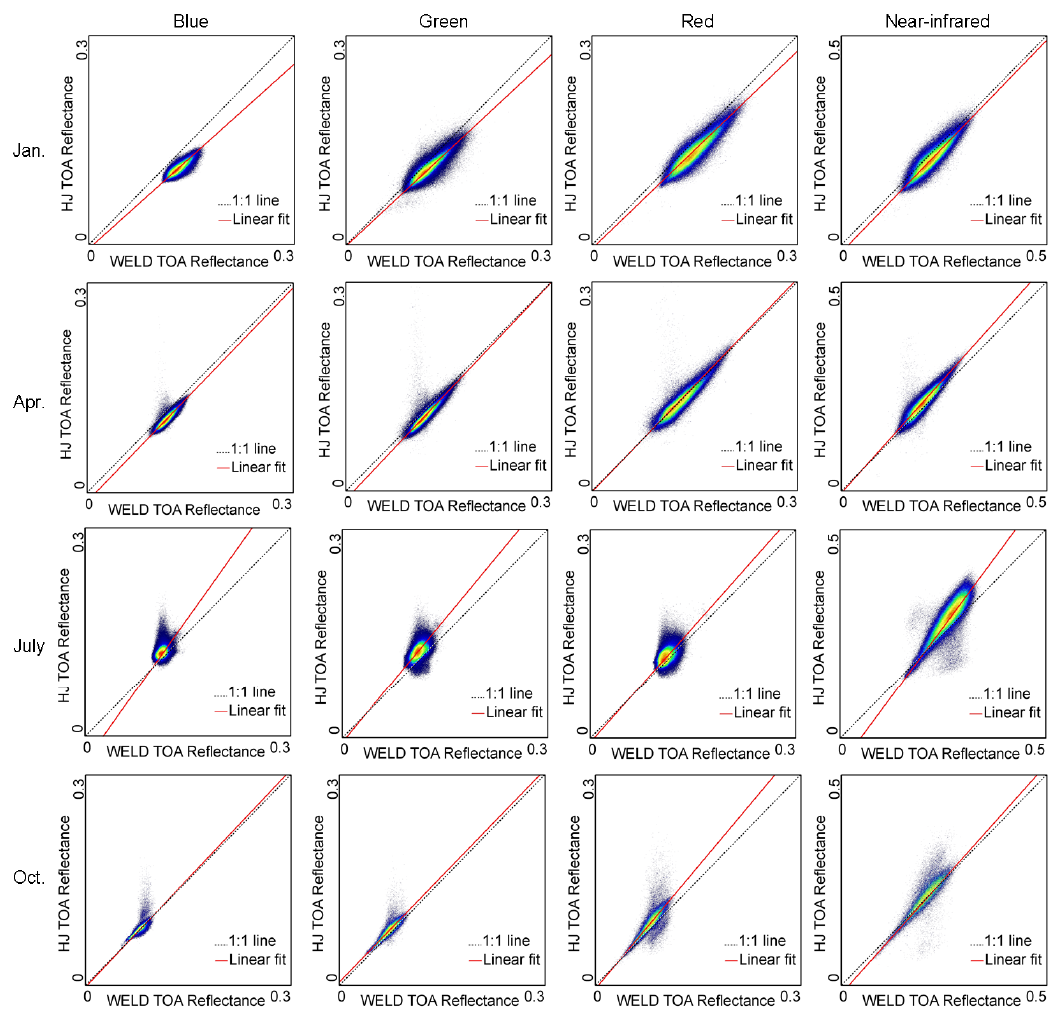
Figure 7. Scatter plots of WELD TOA reflectance bands (X axis) and HJ TOA reflectance bands (Y axis) for the middle month of every season. The standard seasonal definition for the Northern Hemisphere adopted by the climate modeling community is used where spring is defined by the months March to May. Columns 1 – 4 are the scatter plots of Blue, Green, Red and Near-infrared bands, respectively. The red solid lines show linear fitted results of the scatter points. The dotted lines are 1:1 lines for reference. Correlations between HJ and WELD were much lower from May to August. Figure 7 showed that the all scatter plots in July deviated from 1:1 line, which indicated there were distinct changes between the two composites. The ranges of R 2 from May to August for each band were 0.0614–0.2663 (blue band), 0.0931–0.3191 (green band), 0.0593–0.3759 (red band) and 0.2739–0.6977 (NIR band), respectively, with mean R 2 ranging from 0.1638–0.5369. To further verify the radiometric consistency of the four months with lower R 2 in Table 2 ( i.e. , May to August), 400 ˆ 400 pixels subset